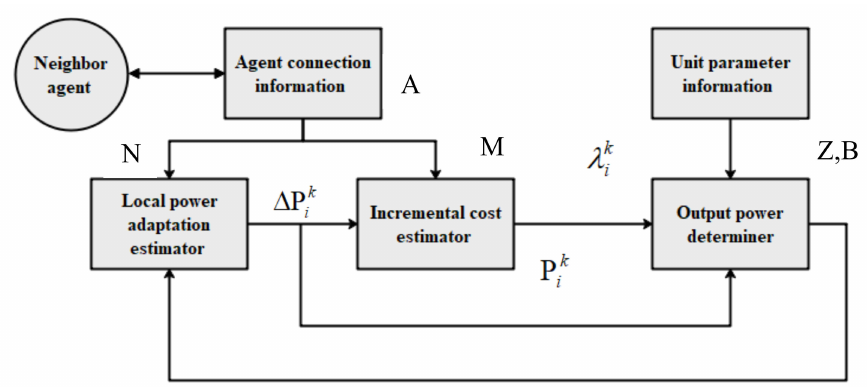
Figure 3. The execution process of distributed energy management algorithm under ideal commu- nication conditions. ∆ P k represents the power mismatch estimation vector, λ k i incremental cost vector, and P k represents the local power demand i